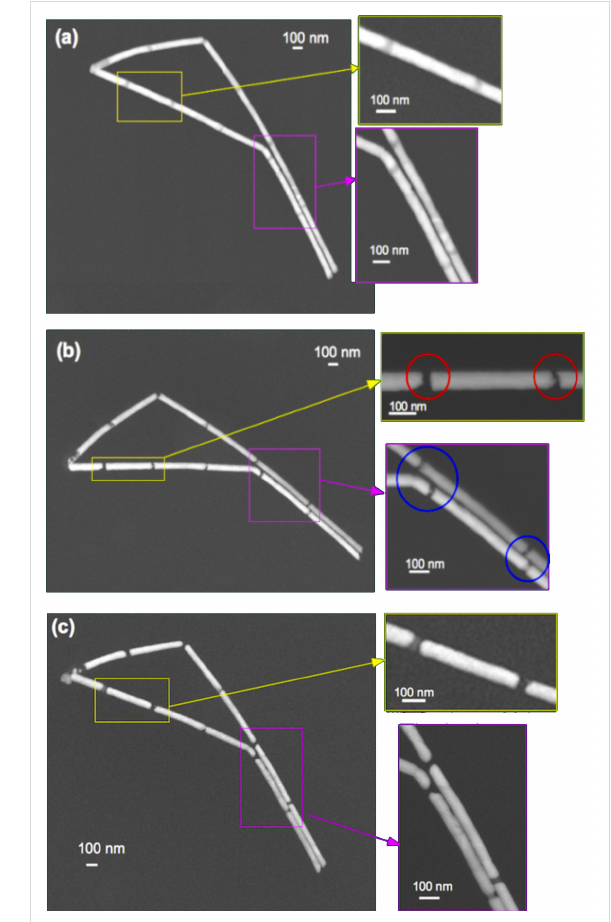
Figure 5: (a) SEM image of two segmented nanowires obtained from a pulse sequence of 6 pulses at − 1.1 V for 25 s and 6 pulses at − 0.5 V with a duration of 15 s. (b) The same two nanowires after treatment with nitric acid. (c) Nanowires after nitric acid treatment and annealing at 300 °C for 30